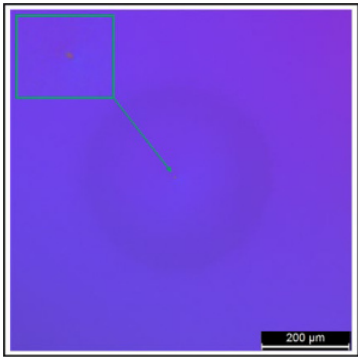
Fig. 2 DIC microscopy image of the investigated damage site (see also Fig. 5) of the SiO 2 coated sample (1064 nm LIDT). The site was irradiated with an energy density of 130 Jcm -2